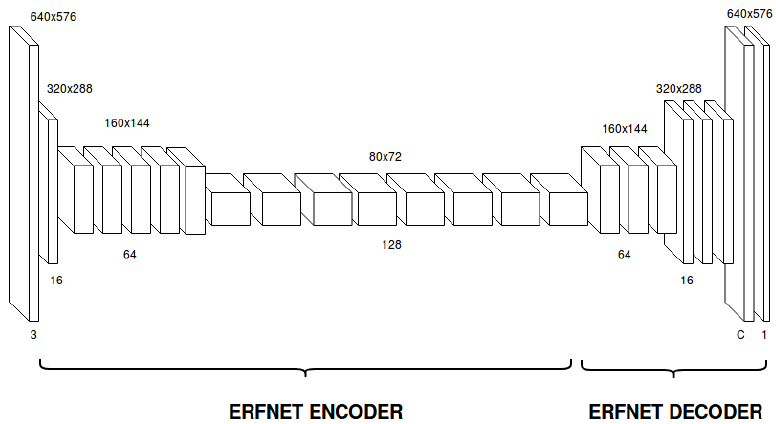
Figure 4. ERFNet baseline